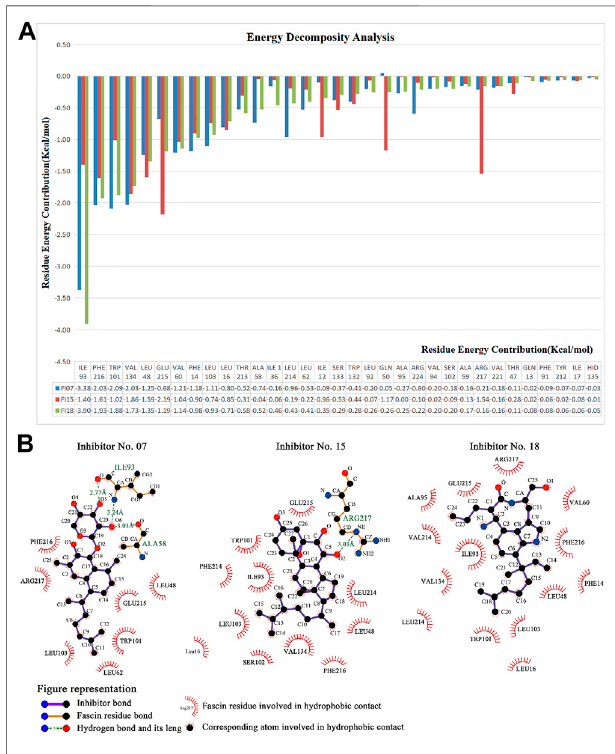
FIGURE 10 | Energy decomposition analysis and interaction networks between Fascin and inhibitors No. 07, 15, and 18. Interaction networks plotted by LIGPLOT Software (Laskowski and Thornton,